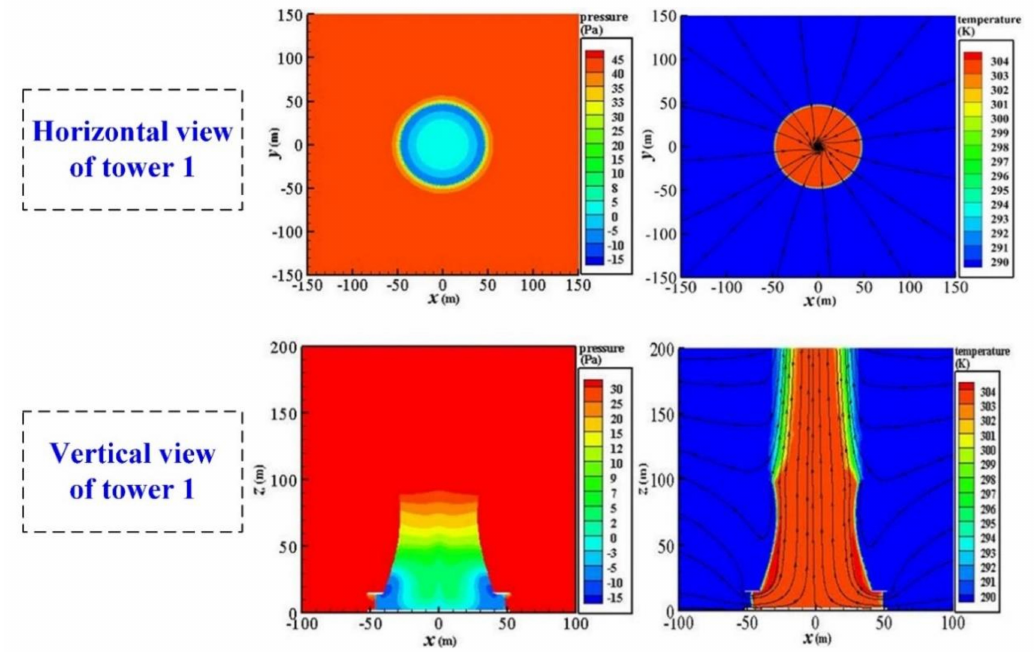
Figure 6. Air variable contours for steel-truss NDDCS with hyperbolic tower configuration without ambient